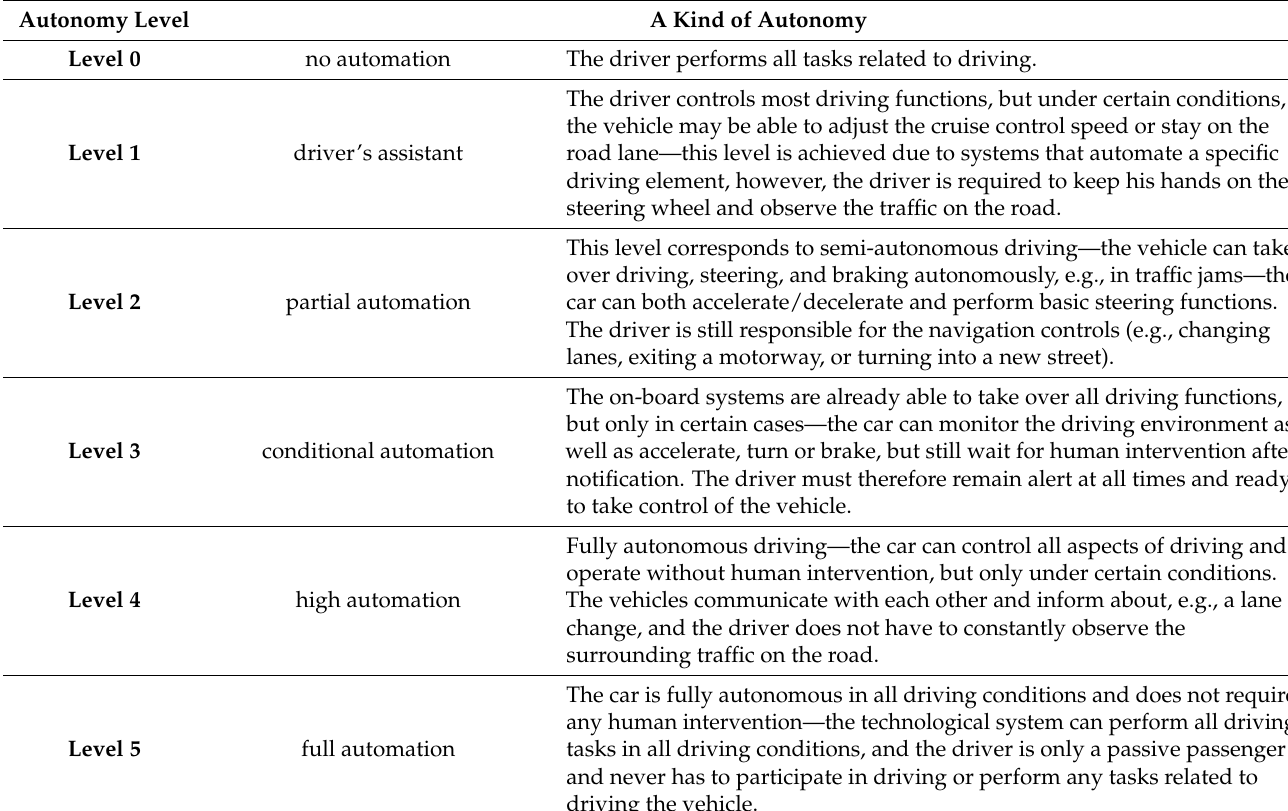
Table 1. Characteristics of the types of autonomy levels implemented in vehicles